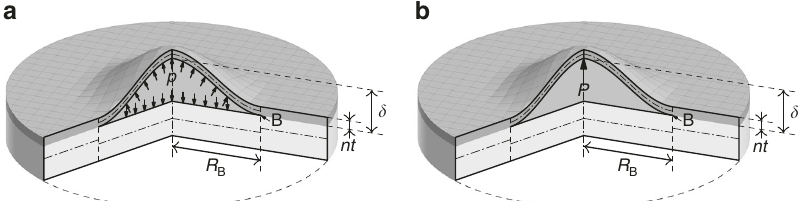
Fig. 1 Circular blister tests to determine the adhesion toughness of mono- and multilayer graphene fi lms. a A blister under a pressure load p . b A blister under a point load